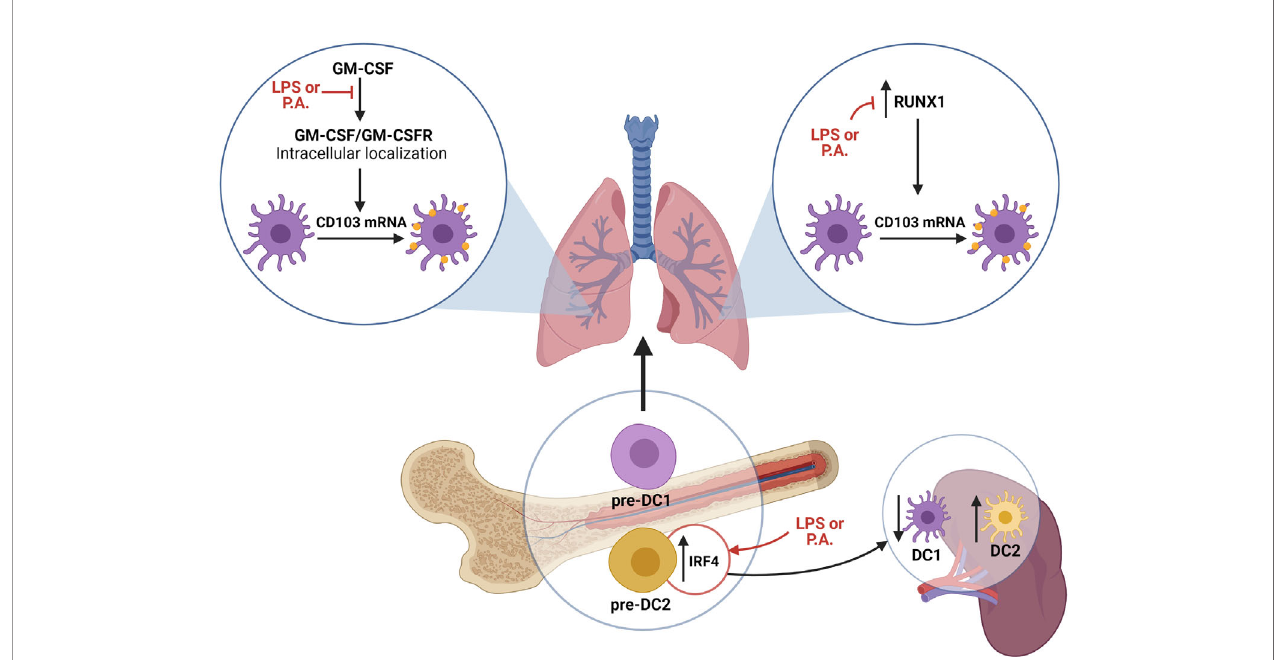
FIGURE 6 | Schematic representation of proposed mechanisms supporting the modulation of lung cDC populations in response to P. aeruginosa. LPS and P. aeruginosa directly impact the capacity of cDCs to internally localize the GM-CSFR, which is a crucial step in GM-CSF signaling leading to CD103 mRNA synthesis and CD103 expression on cDC1s. Additionally, LPS and P. aeruginosa interfere with RUNX1 expression, whose activity is needed for GM-CSF-dependent CD103 expression. Finally, exposure to LPS and P. aeruginosa alters the pre-DC transcriptional signature, favoring cDC2 precursor differentiation. Altogether, the exposure to LPS and P. aeruginosa impacts the capacity of cDCs to express CD103, as well as the cDC precursor signature. Figure 6 was Created with